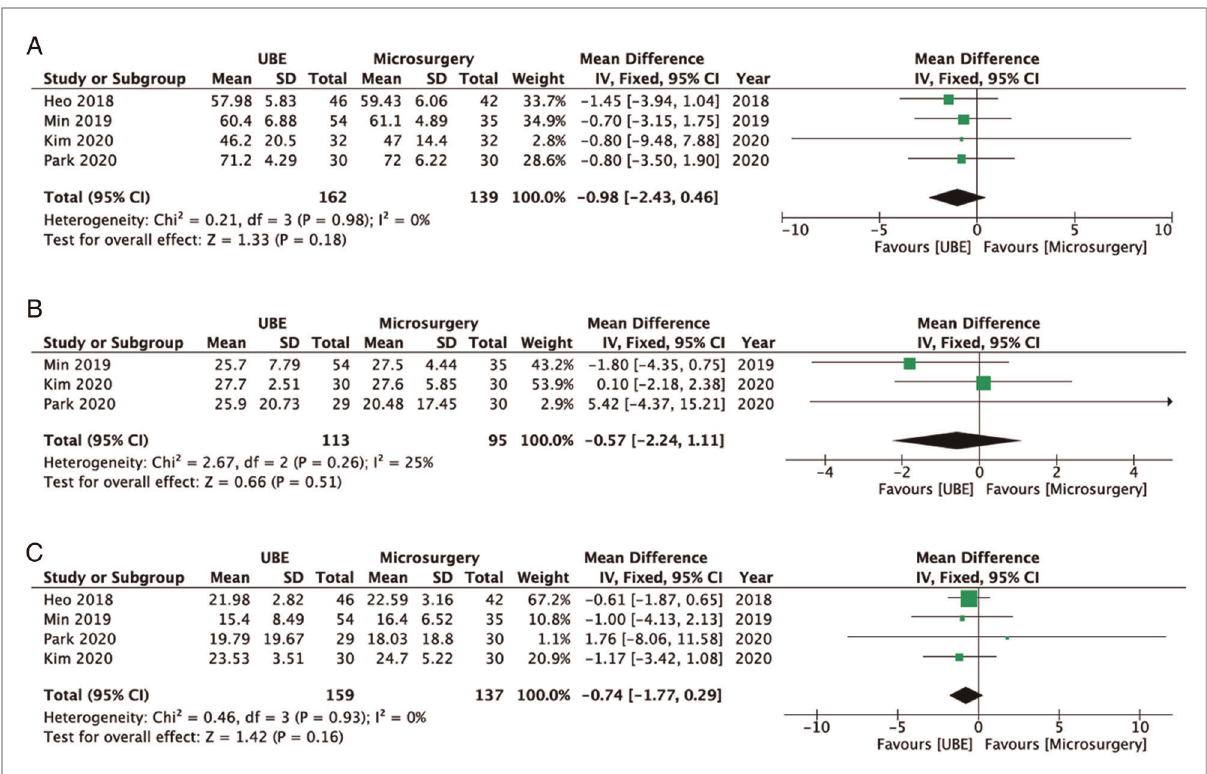
FIGURE 7 Forest plots for comparison of ODI at preoperative ( A ), early (<3 months) postoperative ( B ), and fi nal follow-up ( C ) between UBE ULBD and microscopic ULBD. ODI, Oswestry Disability Index; UBE, unilateral biportal endoscopic; ULBD, unilateral laminectomy with bilateral